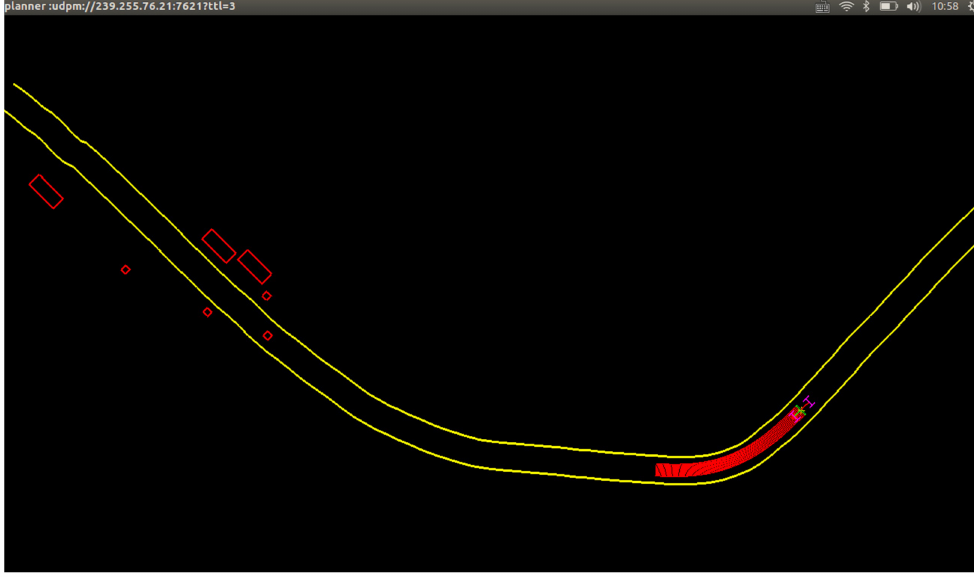
Figure 19. Visualization of the planner module. The yellow line is the driving route planned by the planner module. The red path indicates that the vehicle is slowing down or braking. Rectangles indicate vehicles. Smaller squares indicate